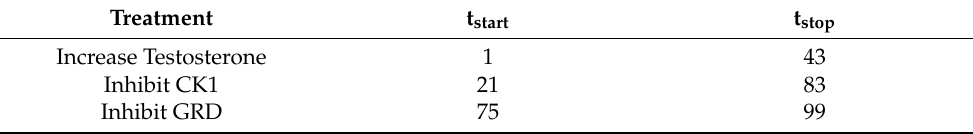
Table 2. The three intervention treatments course starting from SS5 results in a 37% return to health.